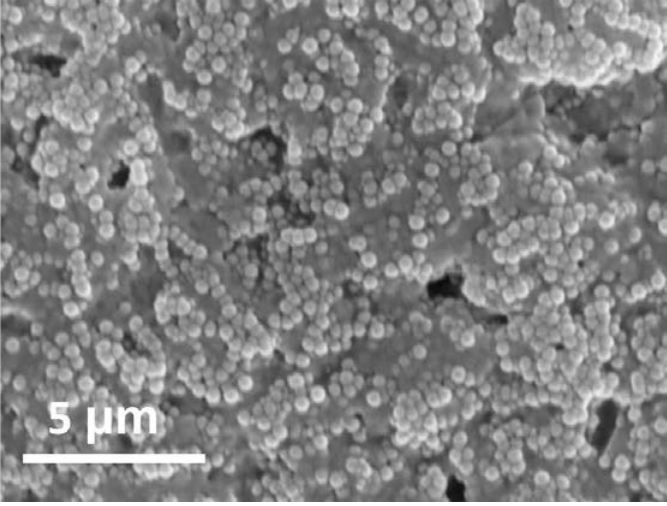
Figure 19. Pseudomonas fluorescence HK44 immobilized with silica particles Ø 306